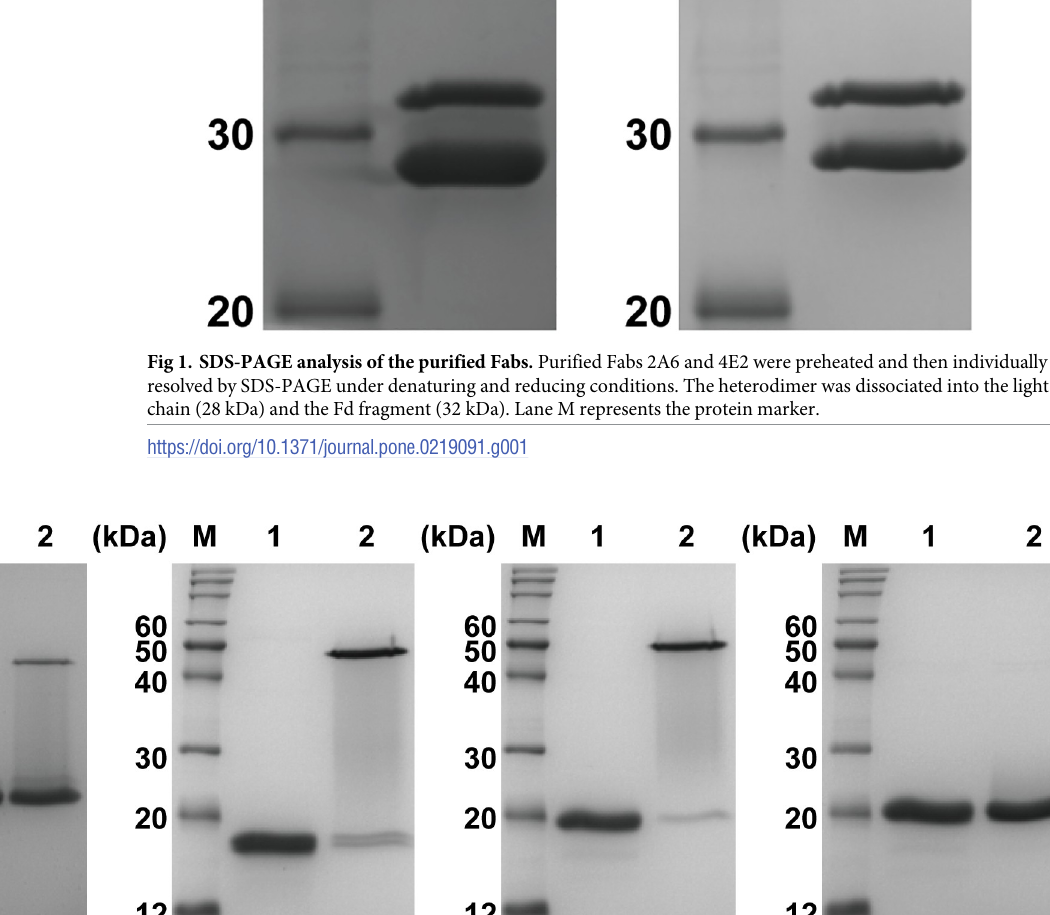
PLOS ONE | https://doi.org/10.1371/journal.pone.0219091 June 26,